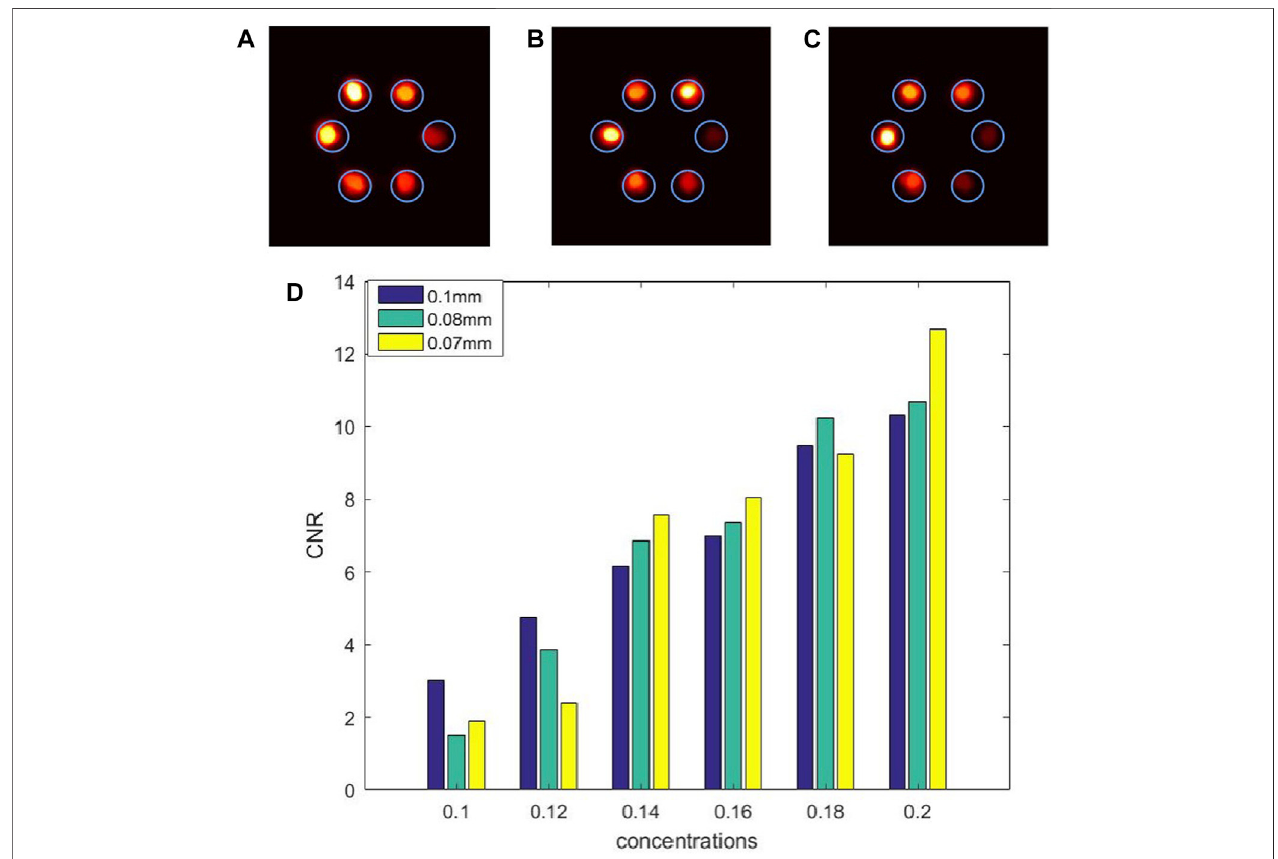
Frontiers in Physics |